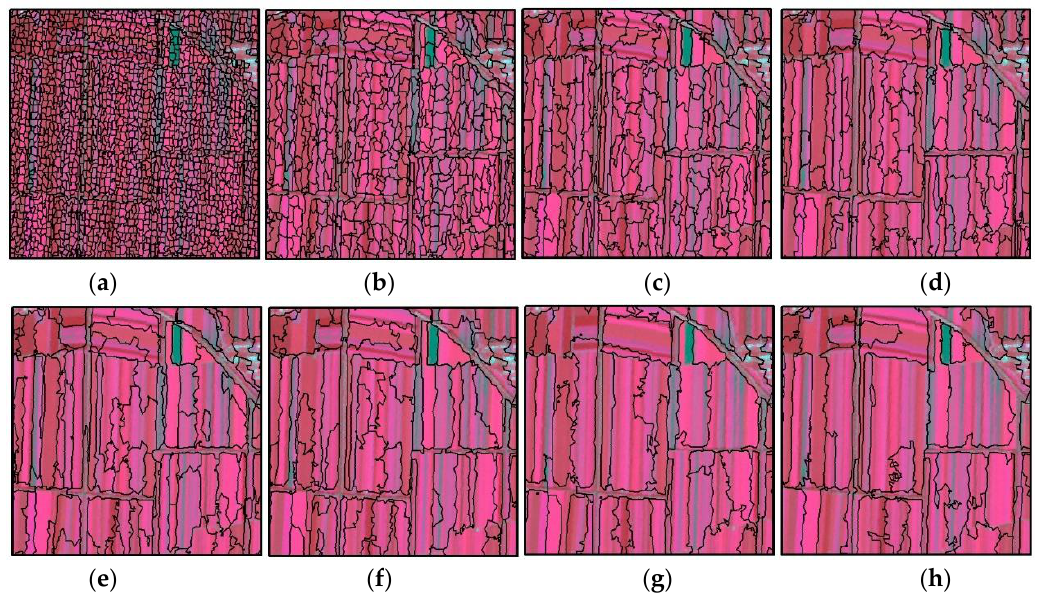
Figure 13. Segmentation effect of different segmentation sizes in Tongnan town. (( a ) size5; ( b ) size10; ( c ) size15; ( d ) size20; ( e ) size25; ( f ) size30; ( g ) size35; ( h ) size40).